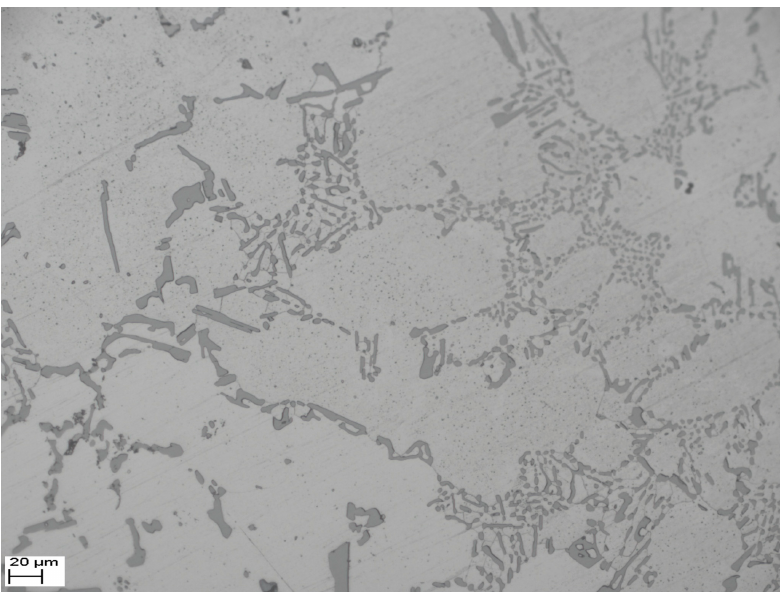
Figure 3. A SEM microstructure graph of the AlSi9Cu2Mg alloy.